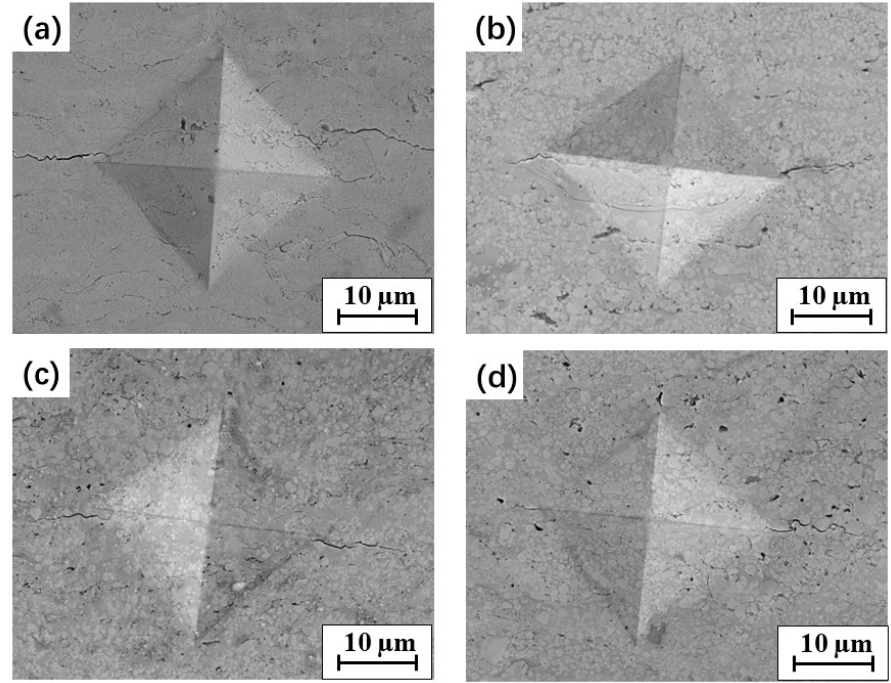
Figure 10. The typical SEM morphology of Vickers indentation imprints on the cross-sections of the studied WC–10Co–4Cr coatings: ( a ) N; ( b ) B1; ( c ) M; ( d ) B2. studied WC–10Co–4Cr coatings: ( a ) N; ( b ) B1; ( c ) M; ( d )